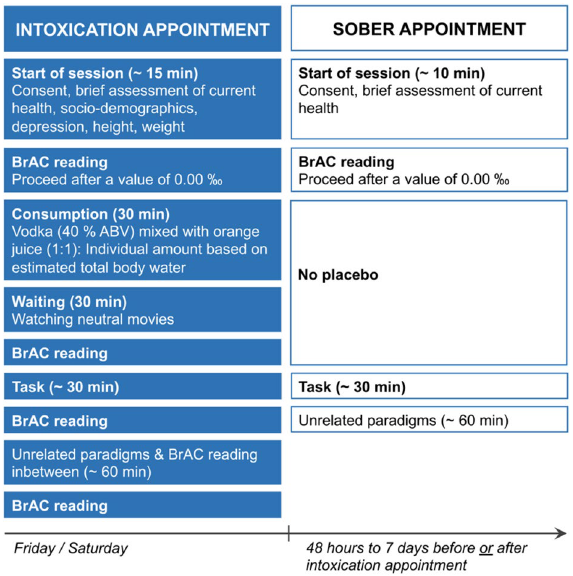
Figure 6. Visualization of the experimental procedure in the intoxication group. Each participant was tested once intoxicated and once sober. Appointment order was balanced across the group.